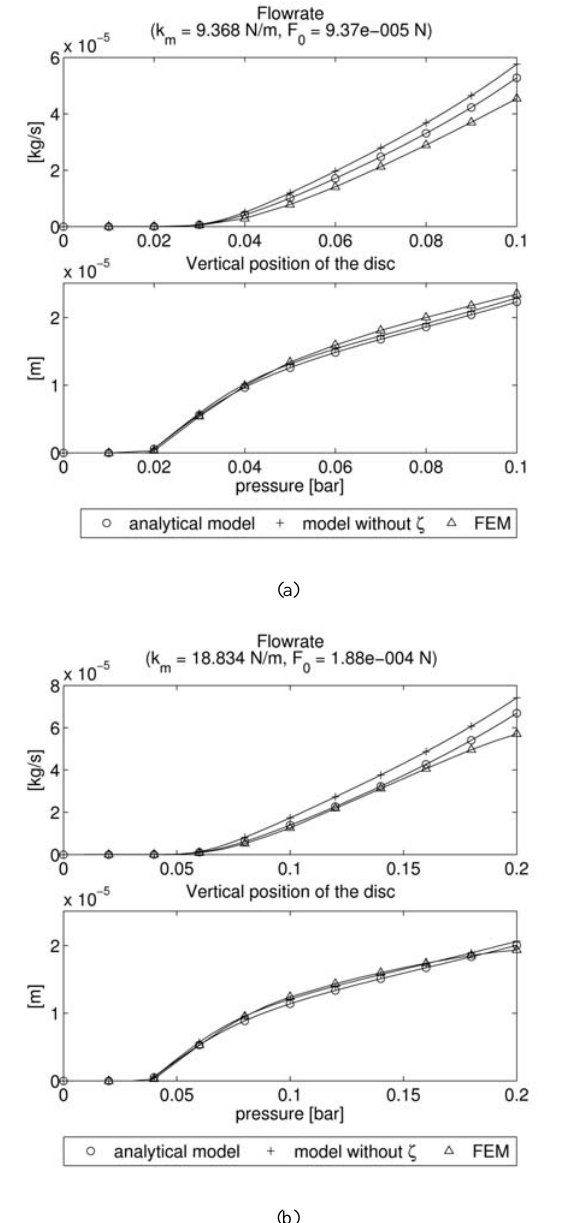
Fig. 7: Comparison of the models for two sets of param- eters. The flowrate through the valve and the vertical po- sition of the disc are plotted versus the inlet